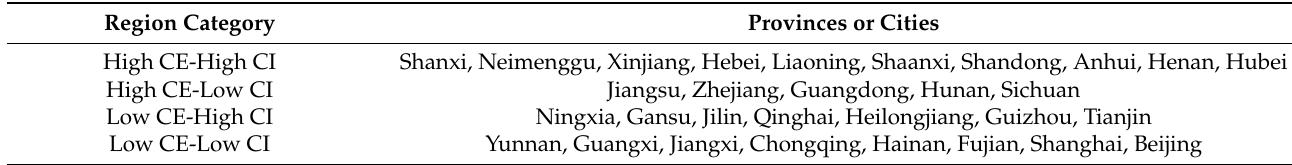
Table 6. Regional division and the related provinces or